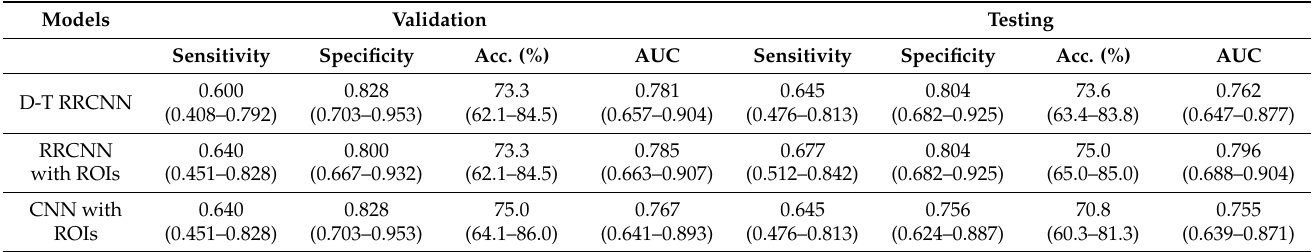
Table 3. Comparison of performance between the three deep learning models. The 95% confidence intervals are listed in parentheses.